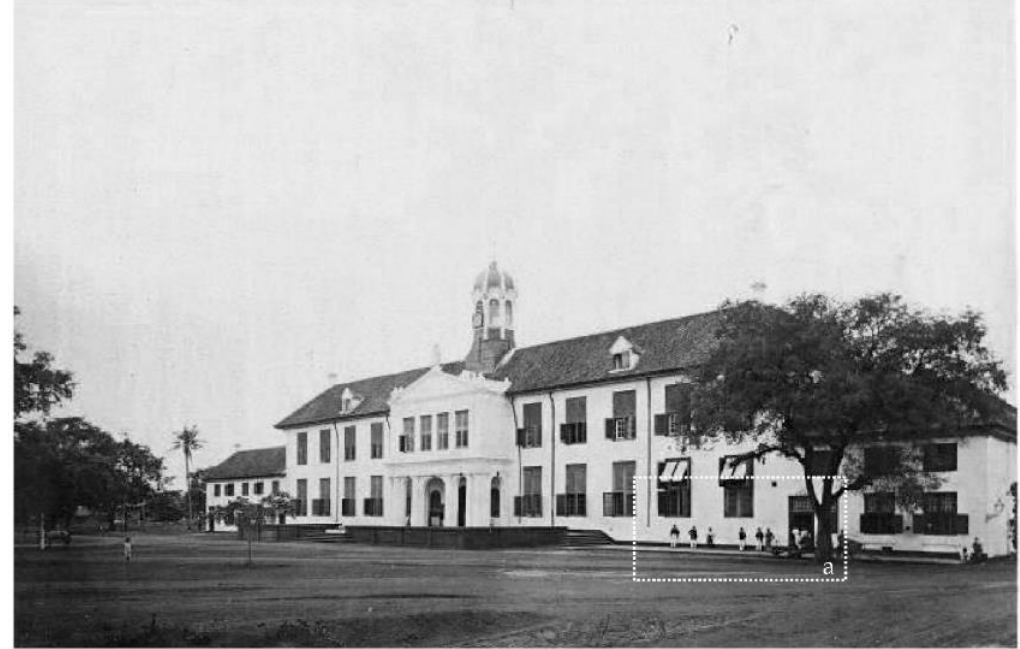
Figure 9. Stadhuis de Batavia and its Stadhuisplein in 1880. Identified sound source: (a) the government officers. Source: Greetings from Jakarta: Postcards of a Capital 1900–1950.